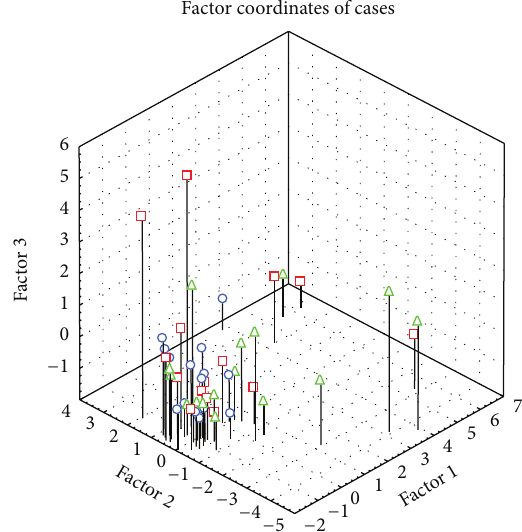
Figure 16: Score plot 3D of the three first principal components obtained by PCA analysis of fluxes collected in D4 ( I ), D5 ( ◻ ), and D6 ( Δ ) from September 2006 to March 2009.